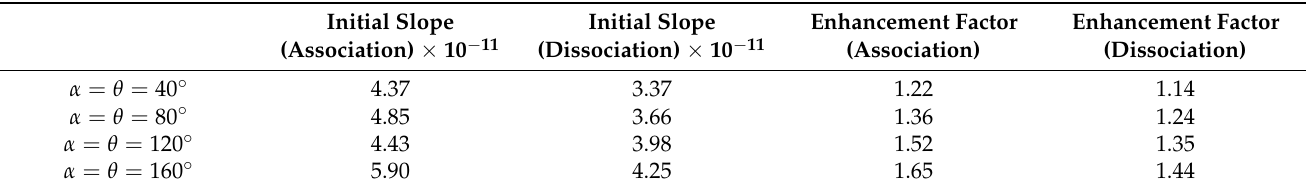
Table 5. Initial slopes and enhancement factors of the binding reactions under 15 V for different values of the electrode aperture angles.